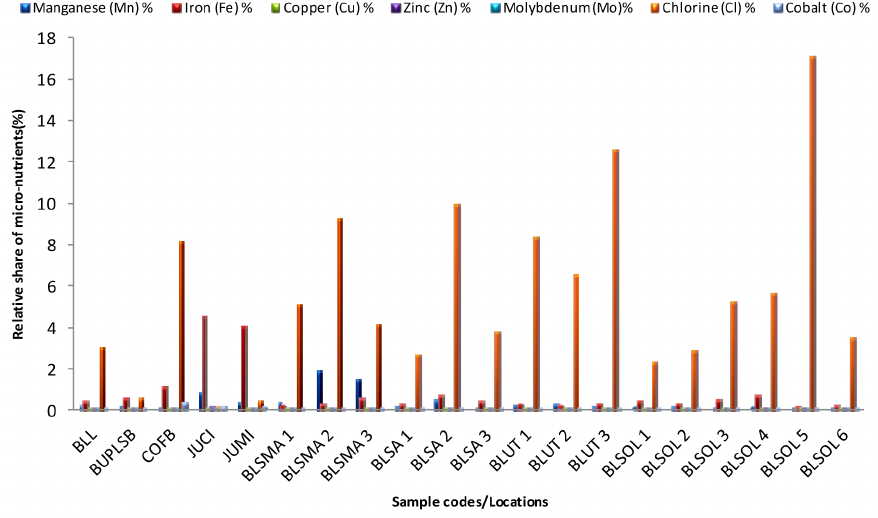
Figure 2. Concentrations of micro-nutrients (% by weight) in ash samples of plant